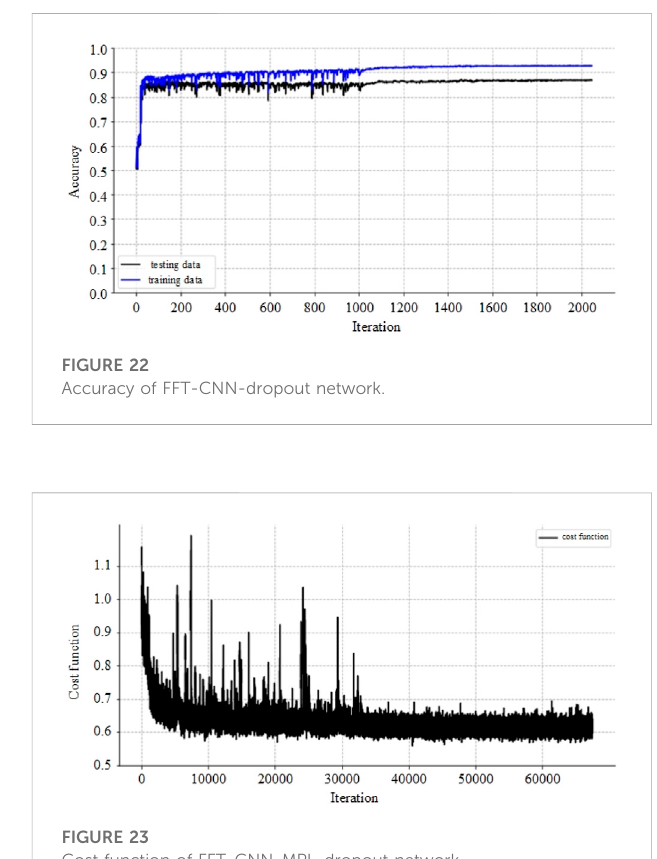
FIGURE 23 Cost function of FFT-CNN-MPL-dropout network.